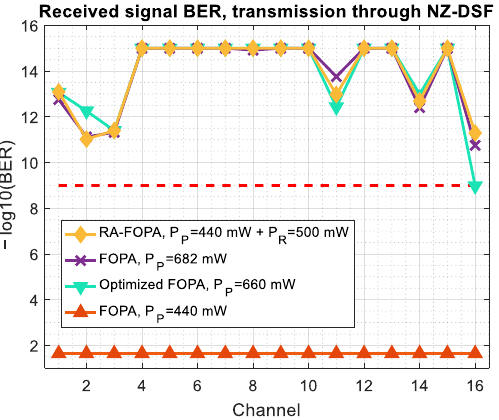
Figure 5. Bit error ratio (BER) distribution between all 16 WDM channels in the case of FOPA and RA-FOPA. Results are limited to BER of 1 × 10 −15 threshold for better visibility. BER evaluation accuracy is up to +/− one order of magnitude. Red dashed line is BER =10 −9 threshold.